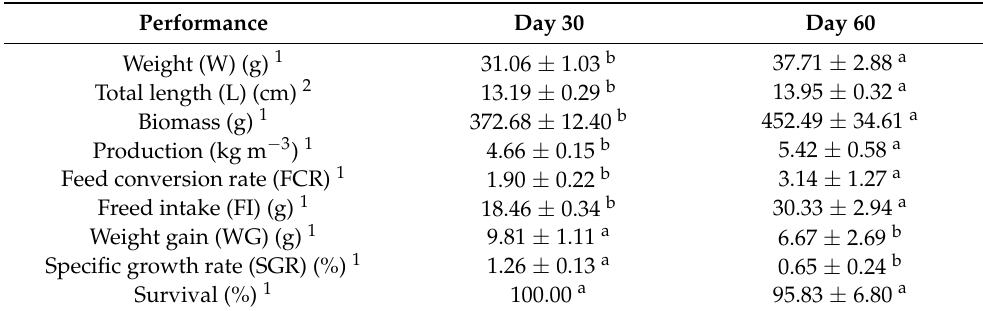
Table 1. Values (mean ± standard deviation) for weight, total length, biomass, feed conversion rate, weight gain, feed intake, specific growth rate, and survival of juvenile Colossoma macropomum at different times (days 30 and 60) during biofloc maturation.